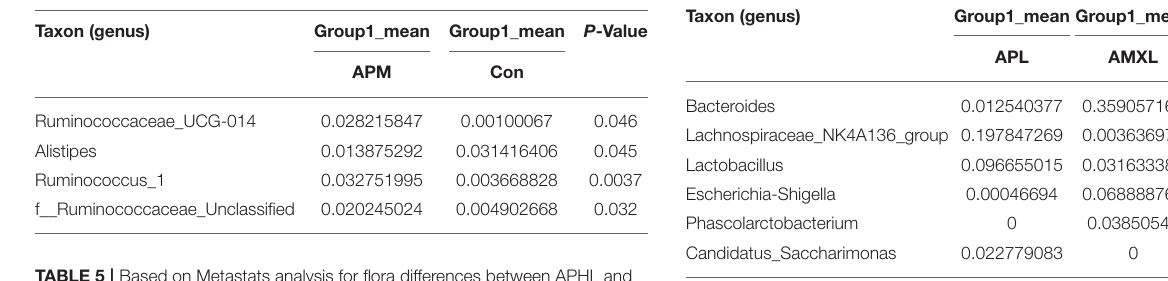
TABLE 9 | Based on Metastats analysis for flora differences between APL and AMXLon groups under the genus.